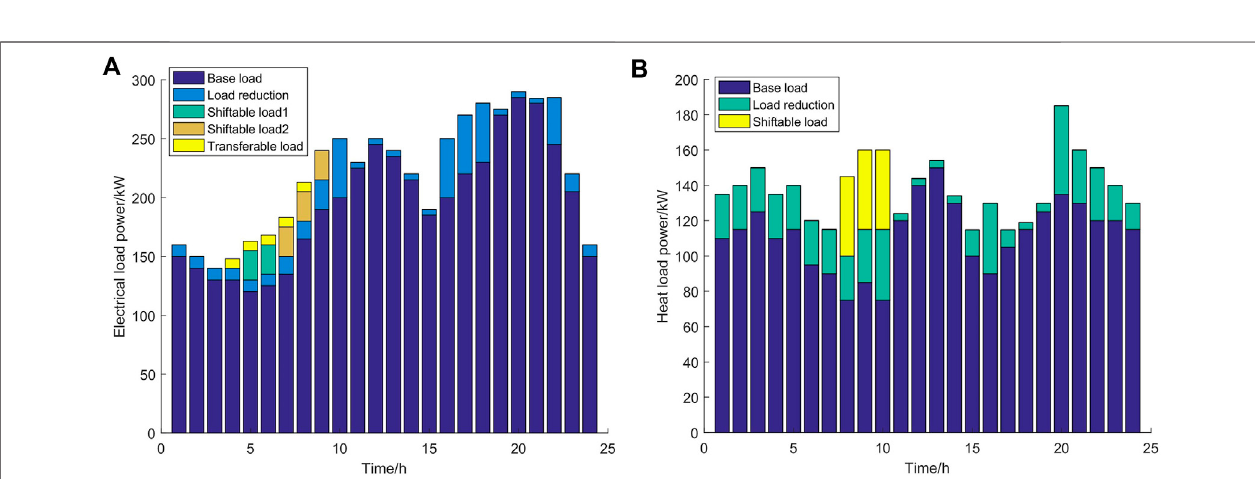
Frontiers in Energy Research |